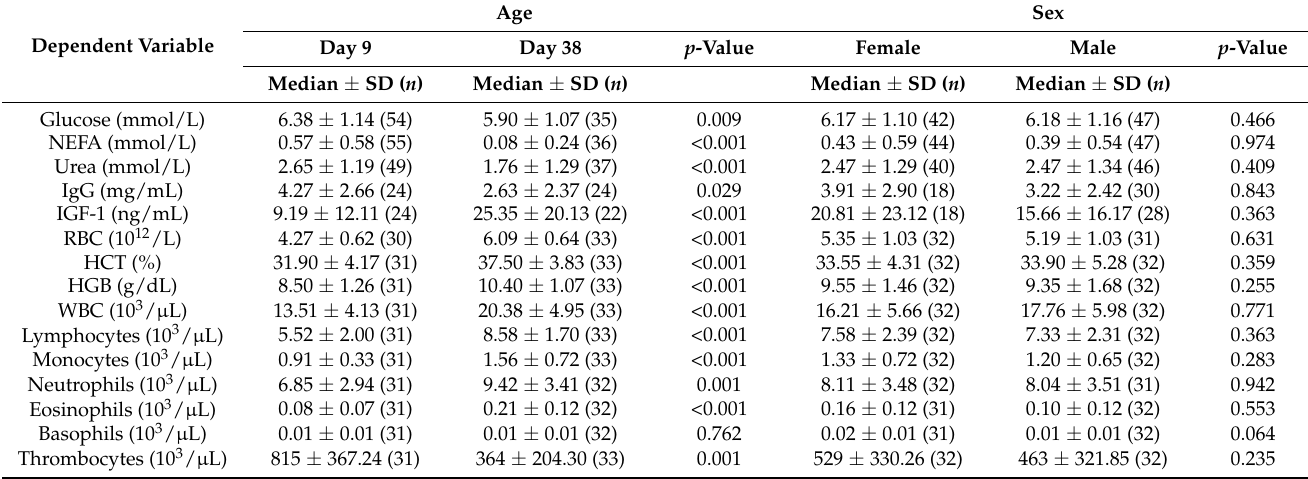
Table 4. Blood values (median ± SD) of glucose, non-esterified fatty acids (NEFA), urea, immunoglob- ulin G (IgG), insulin-like growth factor 1 (IGF-1), red blood cells (RBC), hematocrit (HCT), hemoglob- ulin (HGB), white blood cells (WBCs), lymphocytes, monocytes, neutrophils, eosinophils, basophils and thrombocytes, presented by age and sex from selected low birth weight piglets (linear mixed models, p ≤